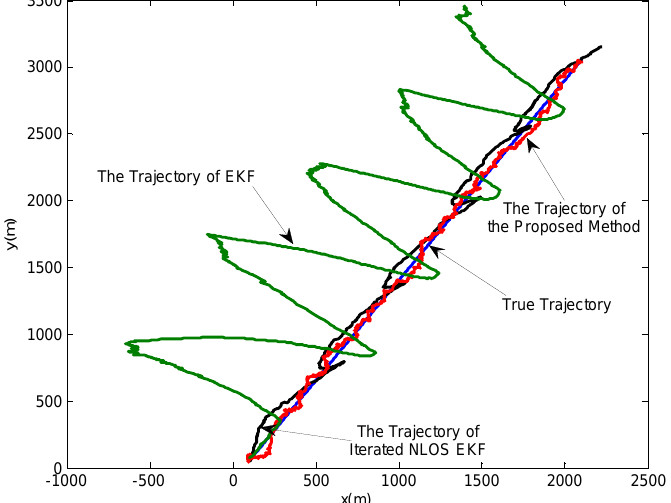
Figure 4. The estimated trajectories of the MN by three algorithms from a single